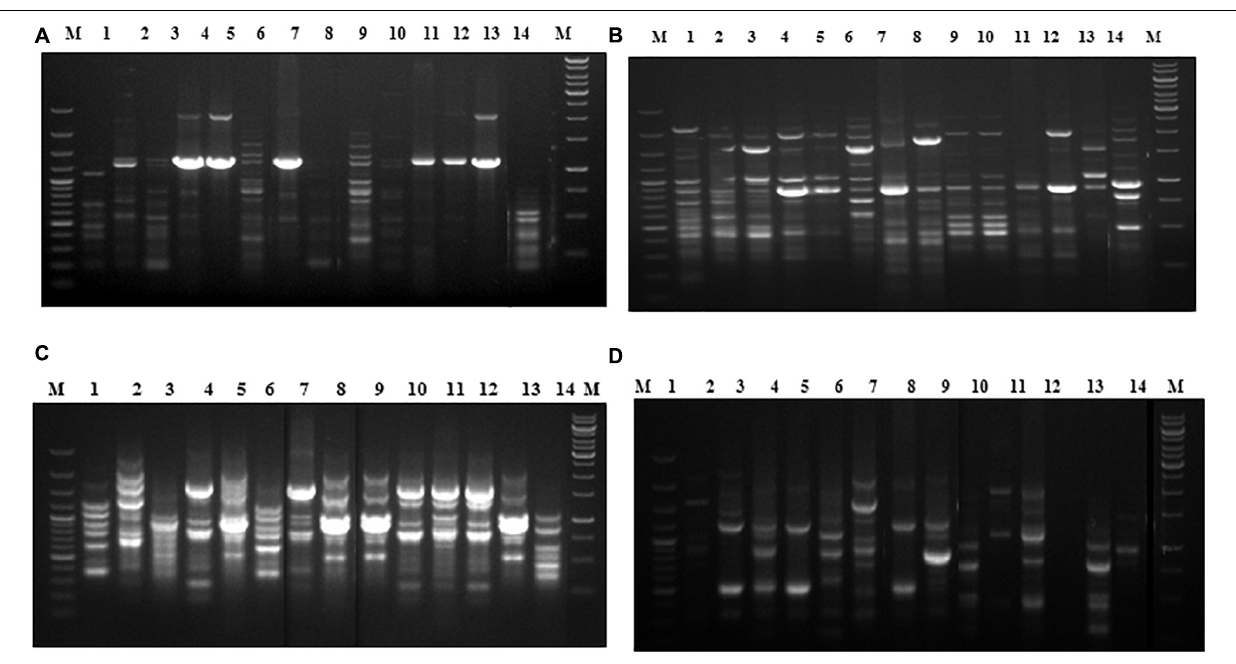
FIGURE 3 | Fingerprinting of Fusarium oxysporum strains with ISSR specific primers, (A) UBC855, (B) UBC 856, (C) ISSR 9, (D) ISSR 10. Lanes (1) 100 bp plus ladder (Fermentas); (2) TOFOL-IHBT; (3) TOFU-2-SOGHI; (4) TOFU-3 B.GHAT; (5) TOFU-IHBT; (6) TOXX- POTI; (7) TOXX-POT2; (8) TOFU-KOTBEJA; (9) TOFOL-CBE; (10) TOFS-CPCT2; (11) TOFS-3-CPCT; (12) TOFU-XM; (13) TOFS-MU; (14) TOFU-4CPCT; (15) TOFU-6-CPCT; (16) 1 kb ladder